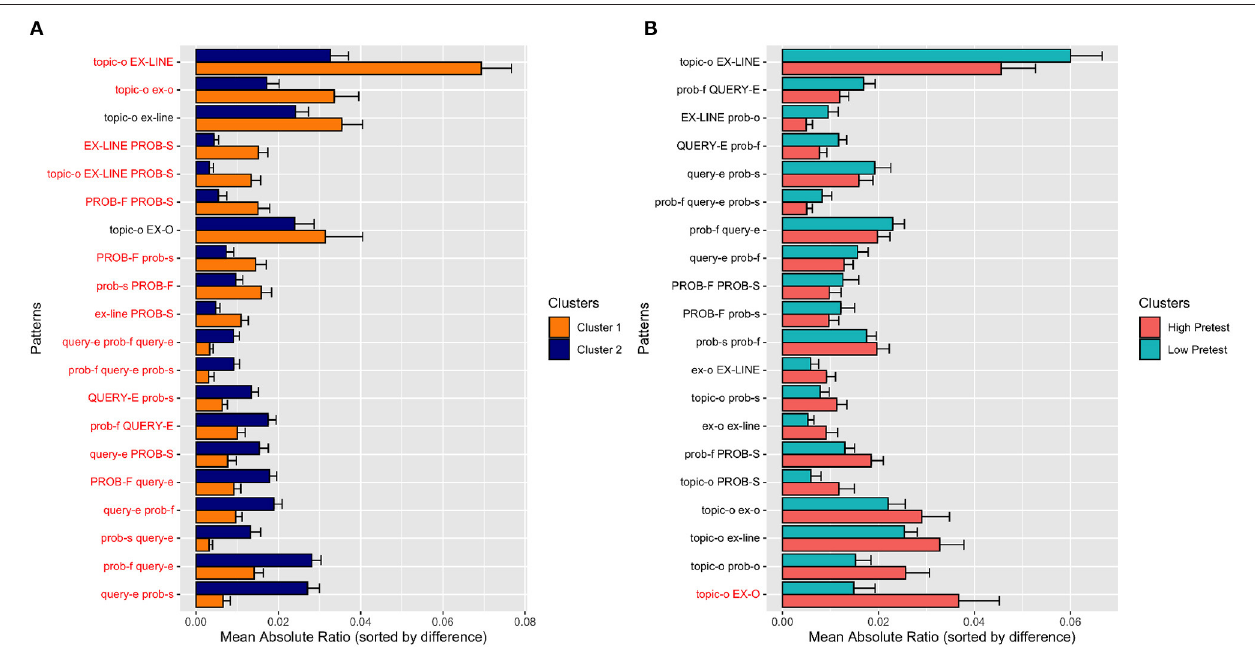
FIGURE 4 | Frequent pattern comparison between (A) discovered clusters and (B) high/low pre-test students. The frequent patterns are selected to highlight the highest absolute ratio difference between two groups, and sorted by mean ratio (probability) difference. Red texts denote significantly different patterns between two clusters, based on the results of the t -test without applying any p -value